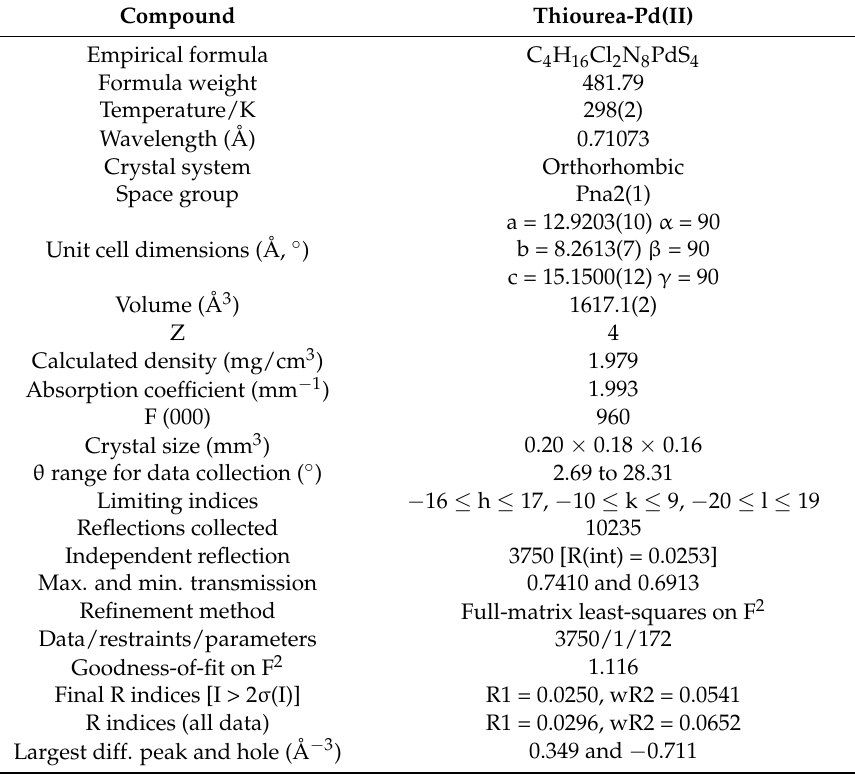
Figure 13. The X-ray crystal structure of thiourea-Pd(II) complex. Table 7. Crystallographic data and refinement parameters for thiourea-Pd(II)